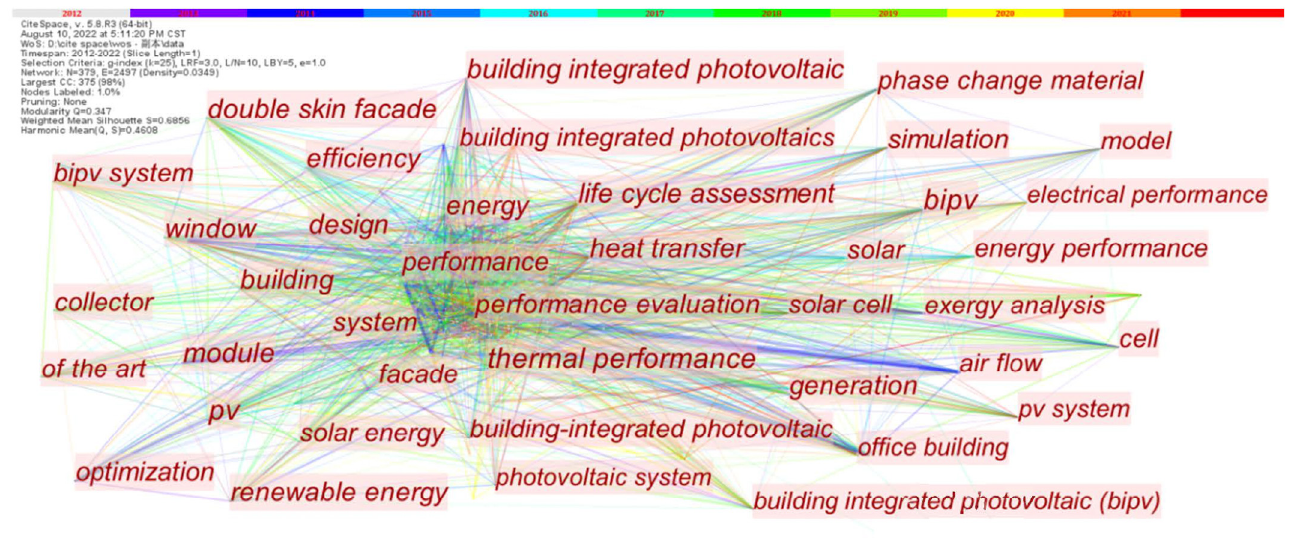
Table 8. The co-occurrence centrality of the top 20 keywords.